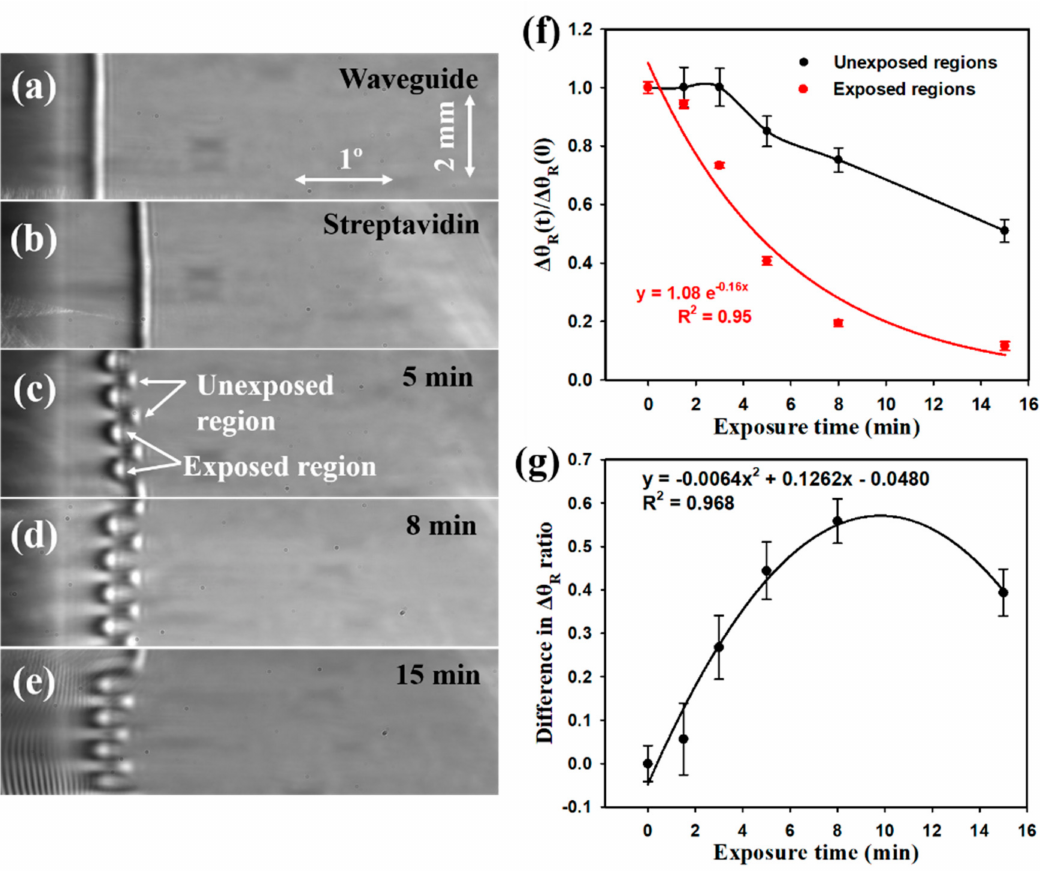
Figure 4. Output of a di ff raction-based LW ( a ) before and ( b ) after streptavidin immobilisation, and its selective removal by exposure to 365 nm light for ( c ) 5 min, ( d ) 8 min and ( e ) 15 min, ( f ) ratio and ( g ) absolute di ff erence of ∆ θ R after and before photo exposure versus exposure